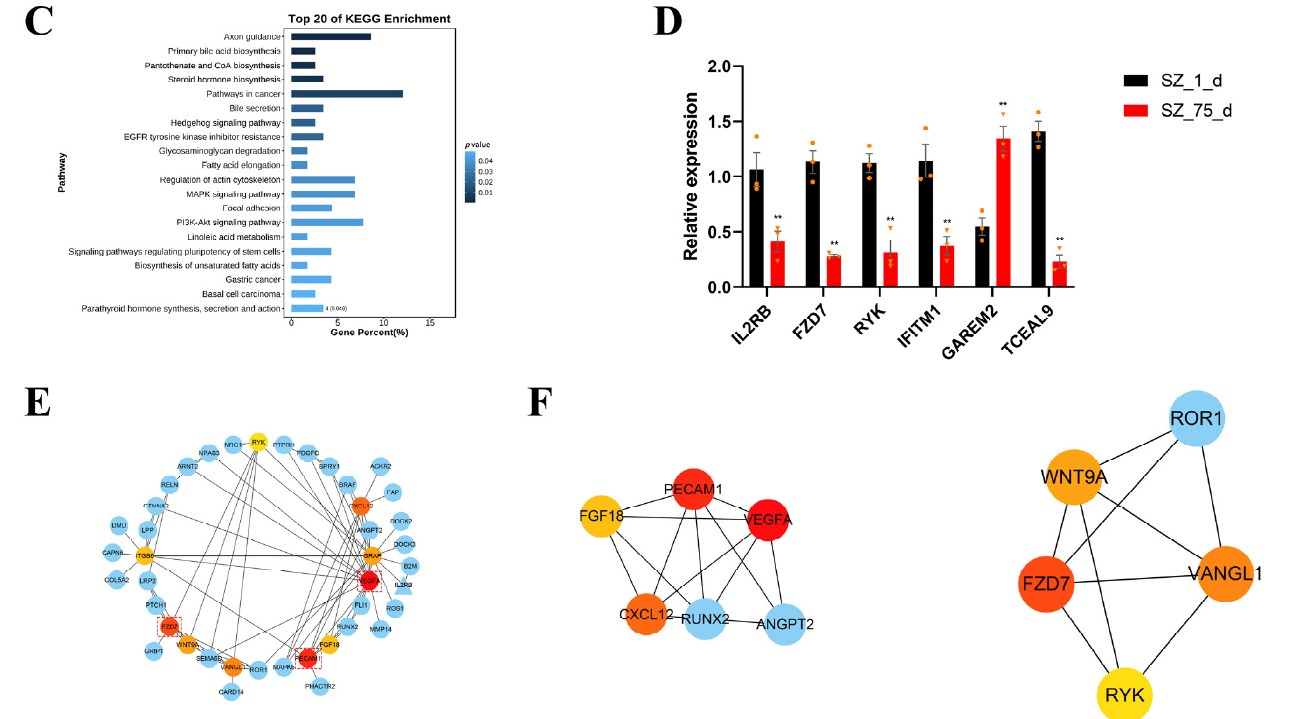
Figure 3. Non-CpG methylation regulated testicular development through multiple pathways. ( A ) GO annotation was performed at Level 2 for three main categories. ( B ) Top 20 GO terms for three main categories. ( C ) Top 20 KEGG pathways. ( D ) The relative mRNA levels of BPGs and PNGs at two developmental stages. The GAPDH gene was used as the internal control. Orange triangles and circles represented the numerical distribution of three biological repeats in each group. Data were presented as the mean ± SEM. ** p < 0.01. ( E ) Identification of hub genes from BPGs and PNGs by STRING and Cytoscape. Top ten hub genes are marked with warm colors, and color changes show the degree of genes calculated by the CytoHubba plug-in. Ellipse—BPGs; and triangle—PNGs. ( F ) Two functional modules filtered out by the MOCODE plug-in.